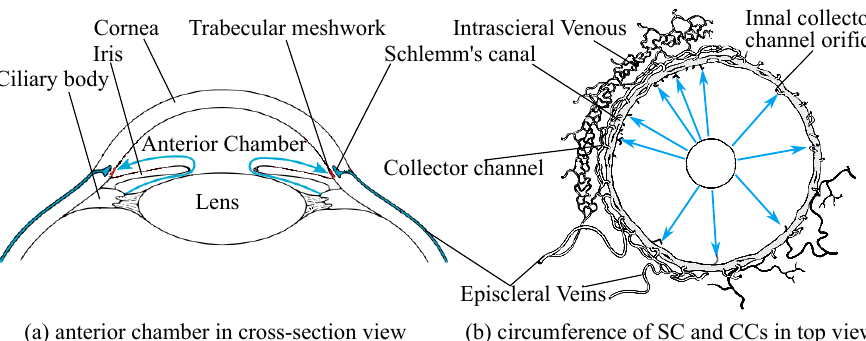
Figure 1. Aqueous humor pathway (repurposed from [4]). Although the morphology of the trabecular meshwork and Schlemm’s canal appear similar around the circumference of the eye, the collector channels orifices are not evenly dispersed around the outer wall of the